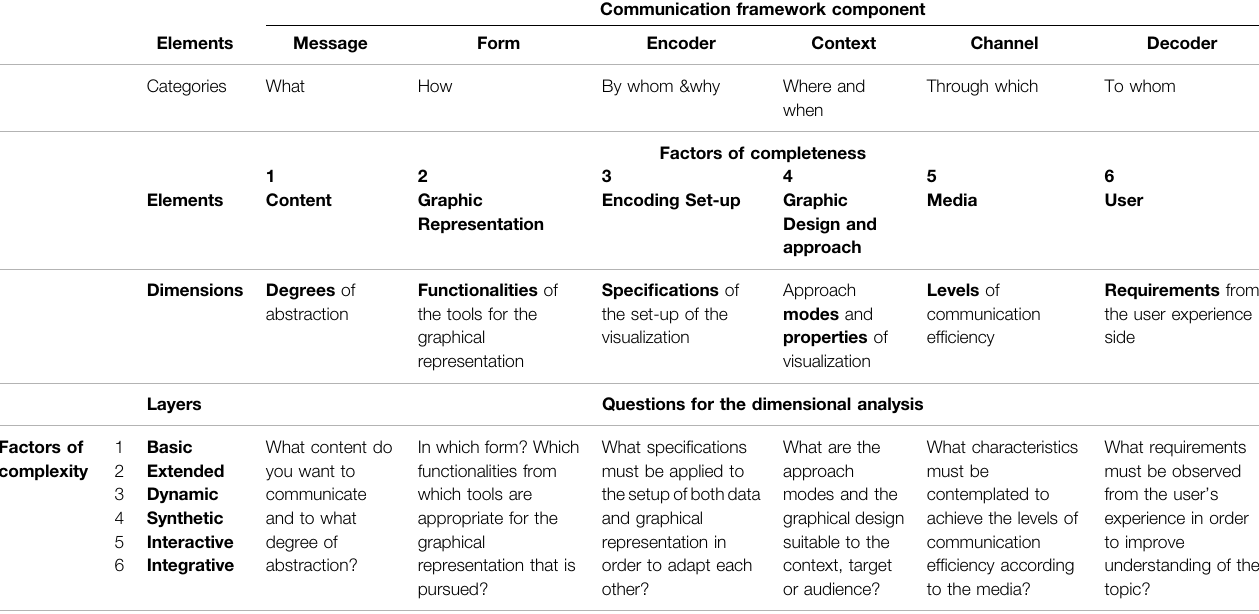
TABLE1| Matrixarchitectureoffactorsofcompletenessandcomplexityforthedesignofthedimensionaltaxonomyofdatavisualizationaccordingtothecomponentsofthe communication framework